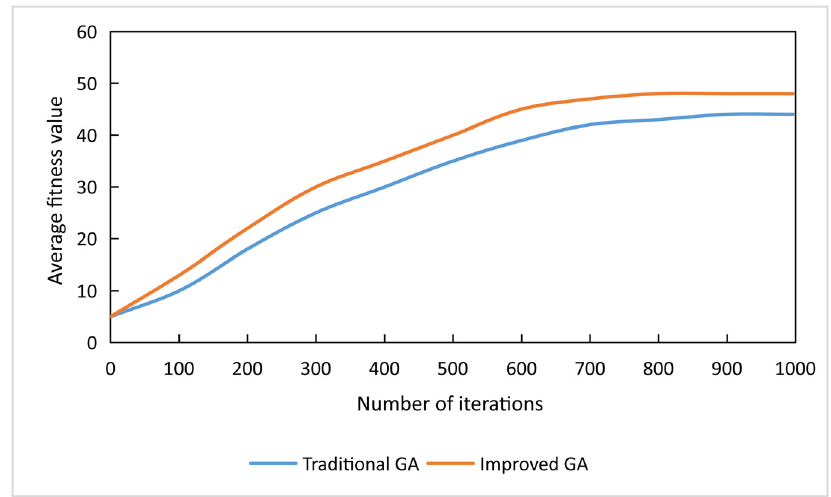
Figure 4: Comparison of traditional and improved genetic